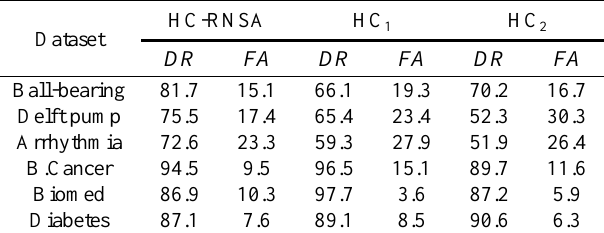
Table 5. Detection result (%) of HC-RNSA, HC 1 and HC 2 under expected coverage